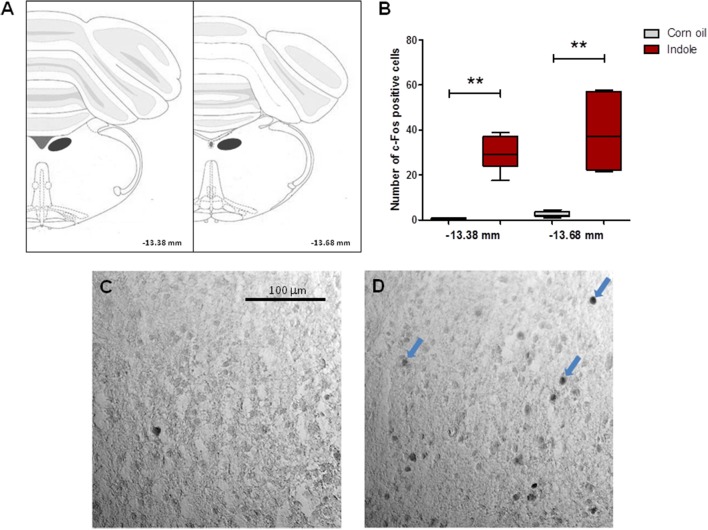
c-Fos immunohistochemistry in the brain of conventional rats treated with indole. (A) c-Fos immunolabeled cells were counted in the DVC (area indicated by a dark oval) at two levels, −13.38 and −13.68 mm from the bregma. (B) Number of c-Fos positive cells in the counting areas after intra-cecal administration of indole (500 mg/kg) or of the corn oil vehicle (n = 5–6 rats/group, Mann-Whitney test). Data are medians with interquartile ranges. **P < 0.01. (C,D) Photomicrographs illustrating c-Fos immunoreactivity in the DVC of the corn oil and indole treated rats, respectively. Arrows indicate c-Fos immunolabeled cells.